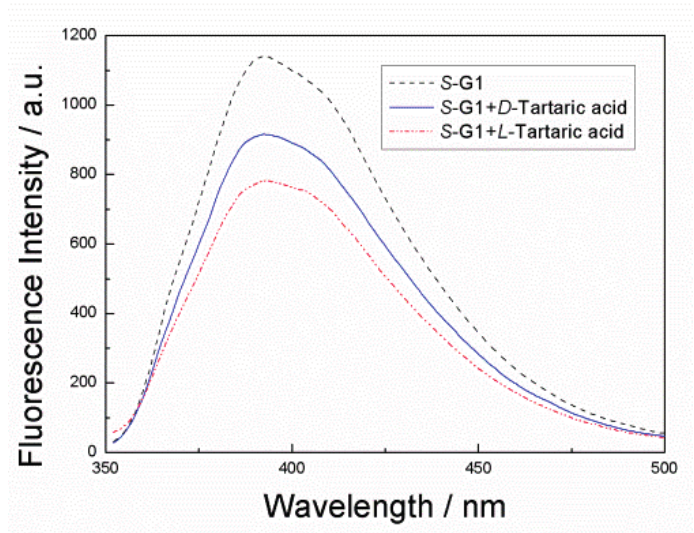
Figure 2. Fluorescence spectra of S -G1 (8 × 10 − 5 mol·L − 1 ) in EtOH solution, S -G1 (8 × 10 − 5 mol·L − 1 ) with D -tartaric acid (1.2 × 10 − 2 mol·L − 1 ) and S -G1 (8 × 10 − 5 mol·L − 1 ) with L -tartaric acid (1.2 × 10 − 2 mol·L − 1 ) ( λ ex = 330 nm) in EtOH solution.